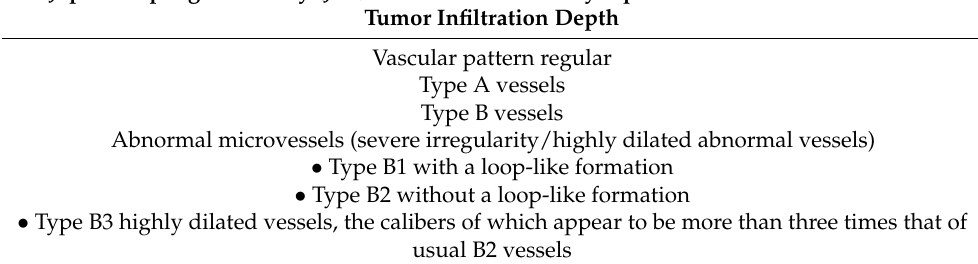
Table 3. Japanese classification for early squamous cell cancer